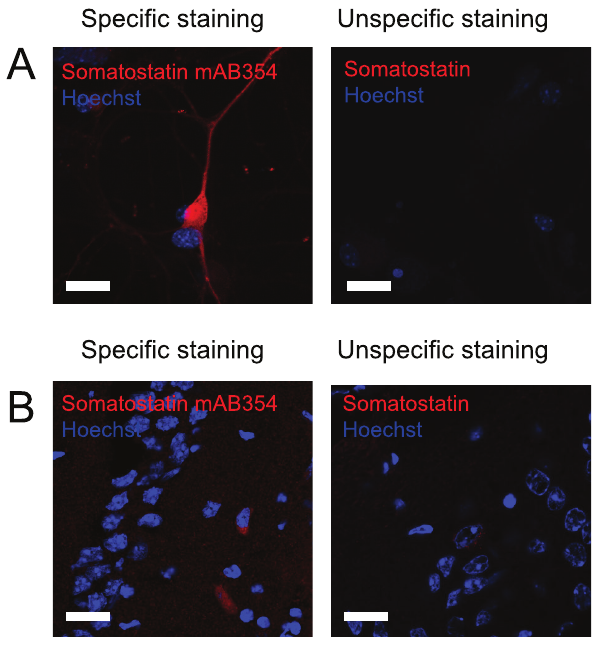
Figure 4. Staining against calbindin. Figure 4 shows immunostaining against calbindin on A ) cultured hippocampal neurons and B ) hippocampal tissue. Left pictures shows an example of an immunostaining considered to be specific while right picture shows an example where immunostaining using other primary antibodies did not meet the criteria and therefore was considered unspecific. Scale bar represents 20